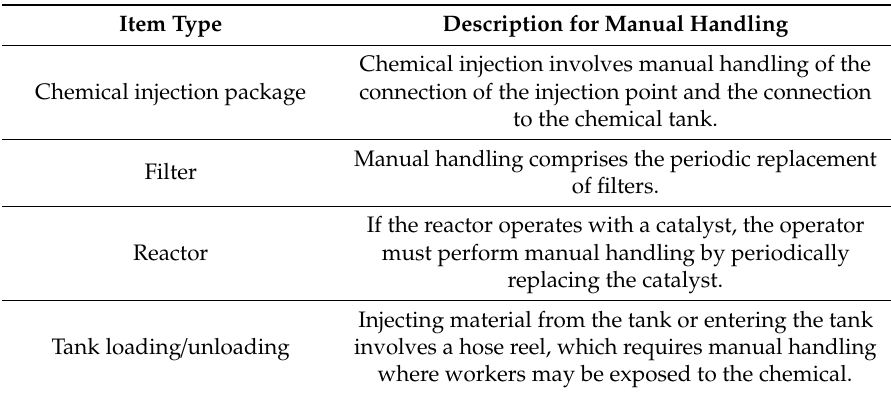
Table 6. Item list for manual operation.